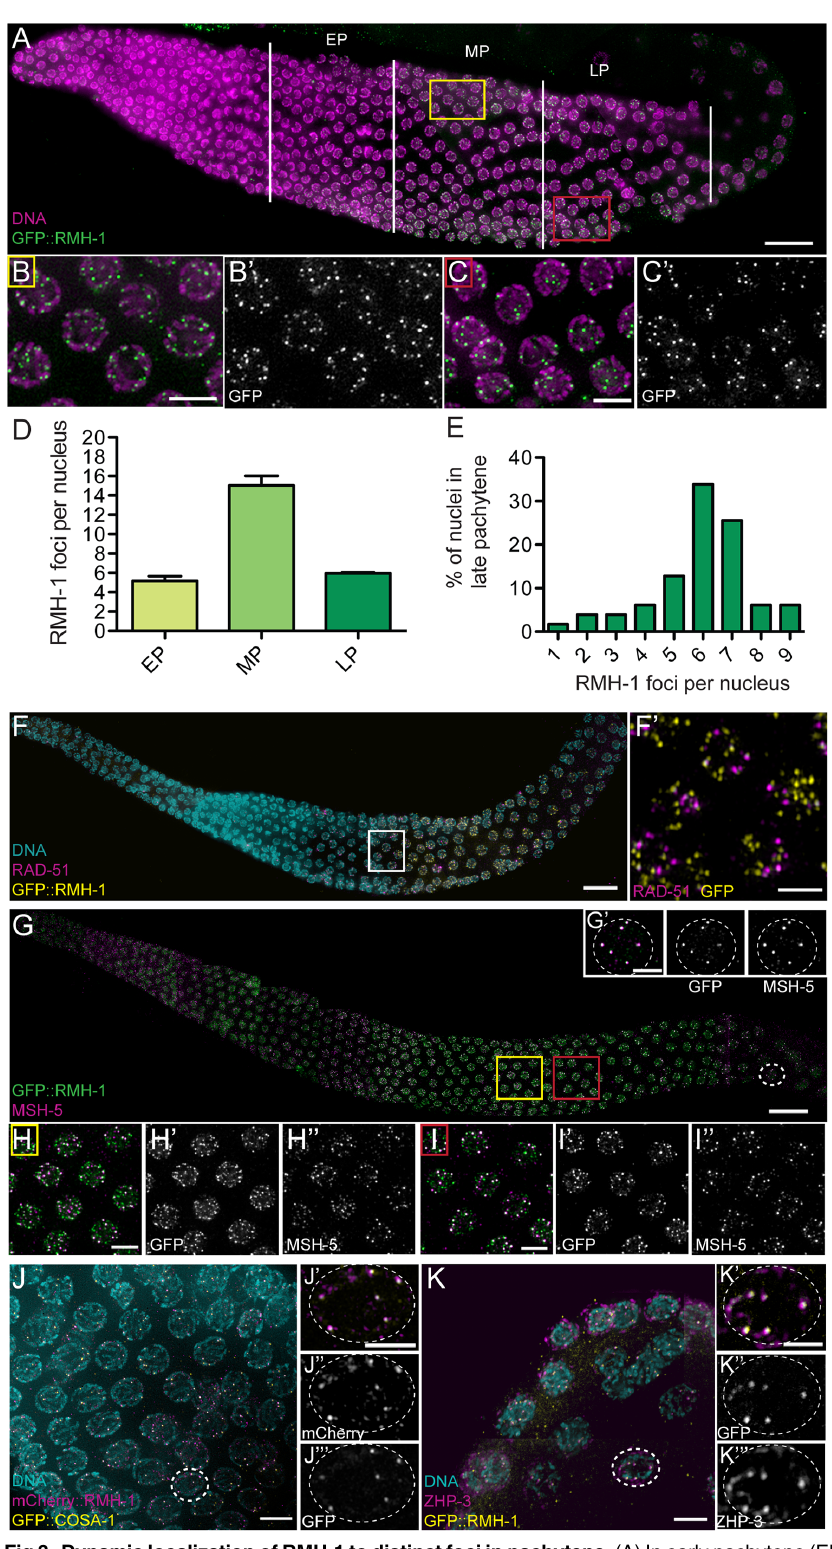
Fig 3. Dynamic localization of RMH-1 to distinct foci in pachytene. (A) In early pachytene (EP), GFP:: RMH-1 is diffuse and few foci are detected on DNA. In mid pachytene (MP), high numbers of foci (up to 25